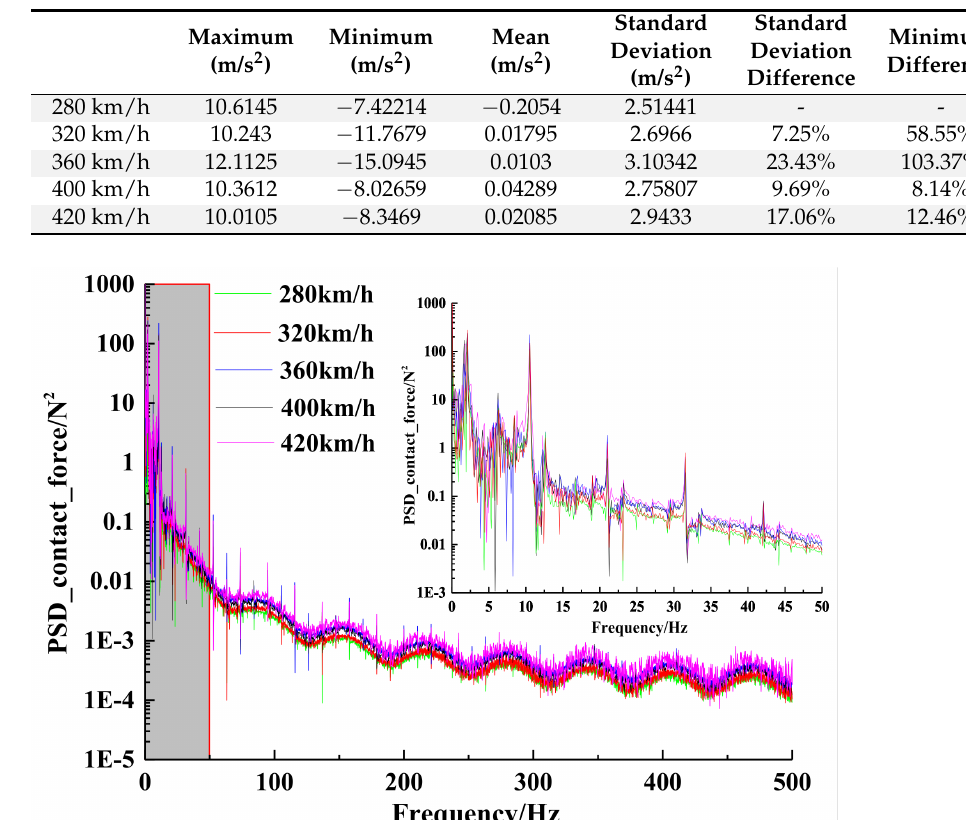
Figure 15. Power spectral density curves of contact force between pantograph and catenary passing through tunnel at different